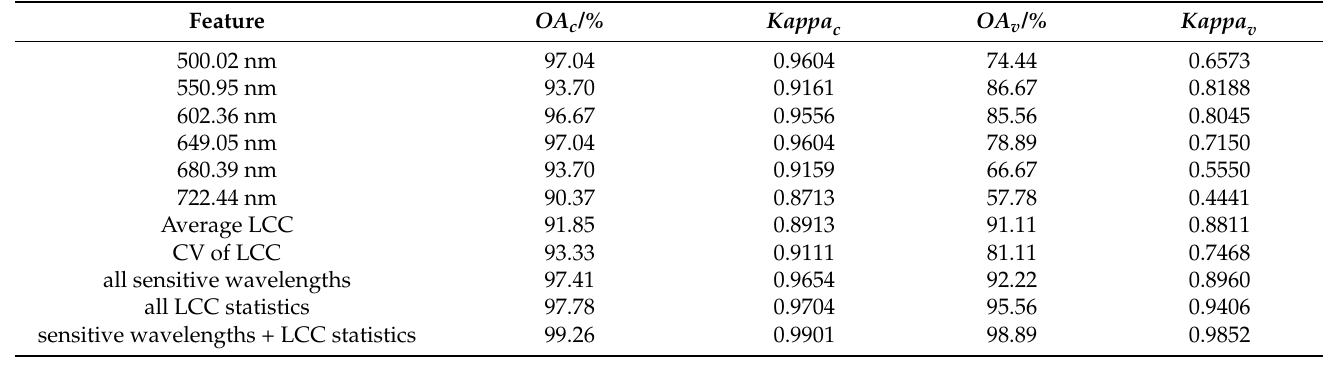
Table 5. Identi fi cation modeling results. Table 5. Identification modeling results.